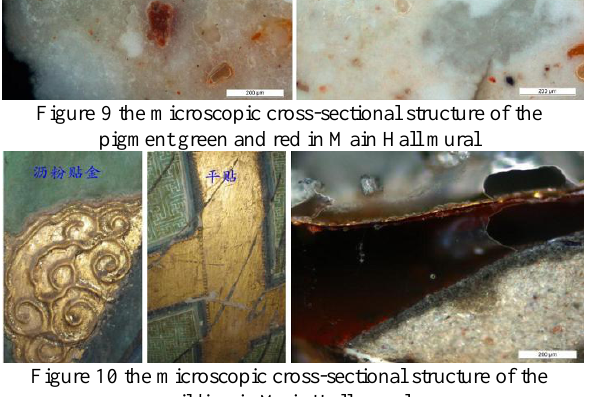
Figure 10 the microscopic cross-sectional structure of the gilding in Main Hall mural